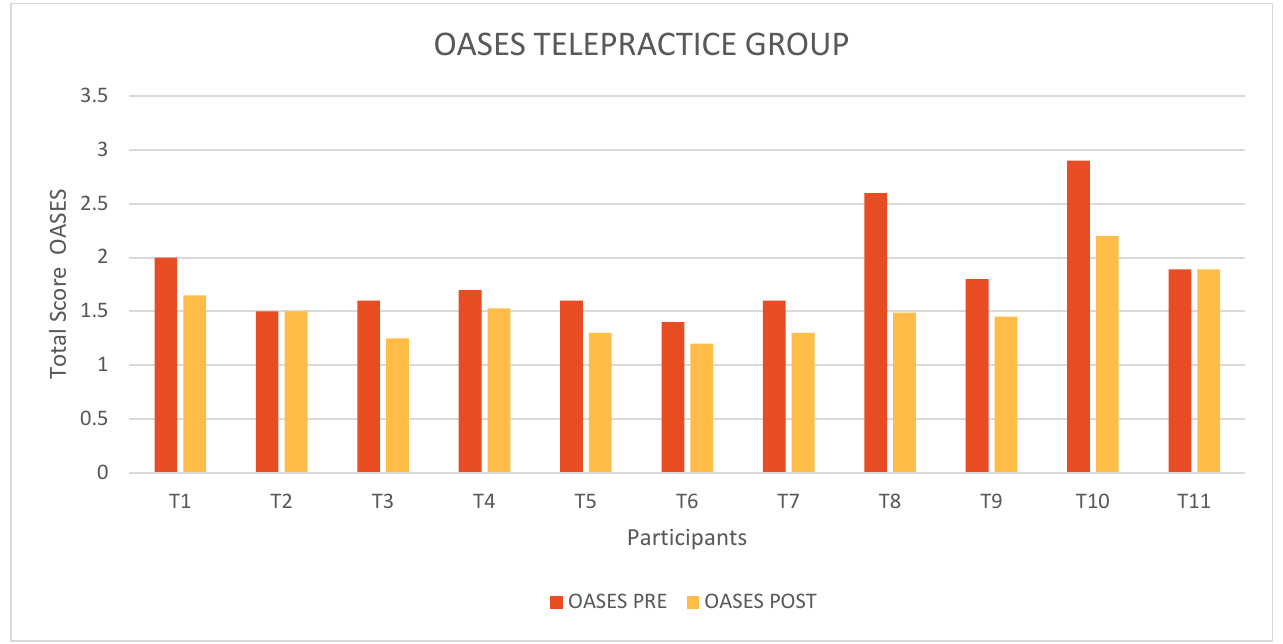
Table 3 summarizes the scores obtained by participants in the Telepractice Group before and after receiving treatment on the SSI-4 and OASES tests.